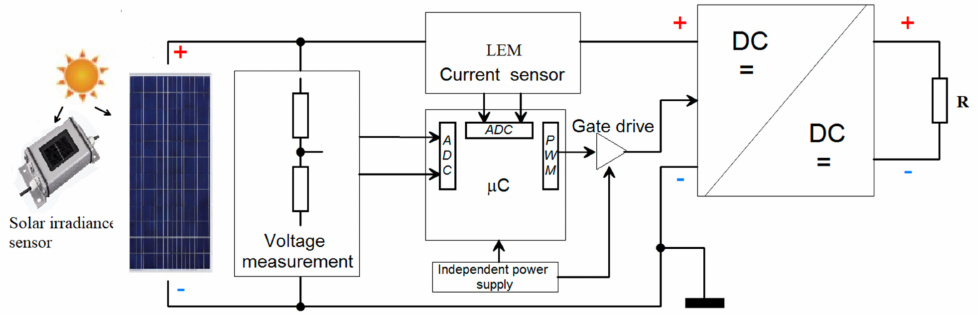
Figure 24. The block diagram of the PV